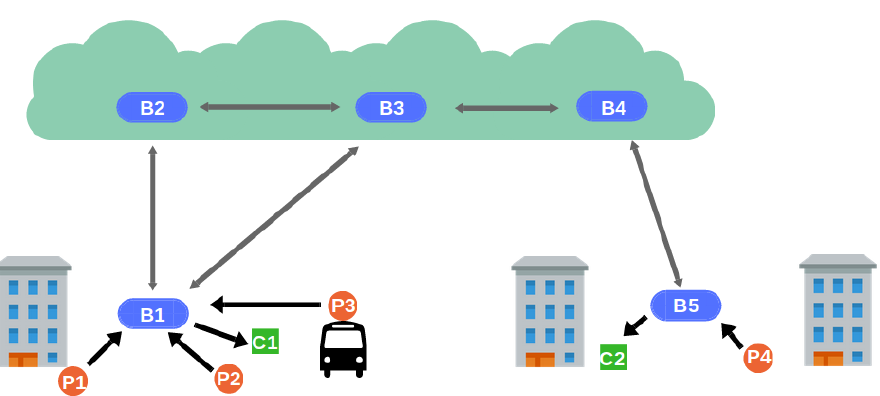
Figure 2. Fixed-brokers architecture.